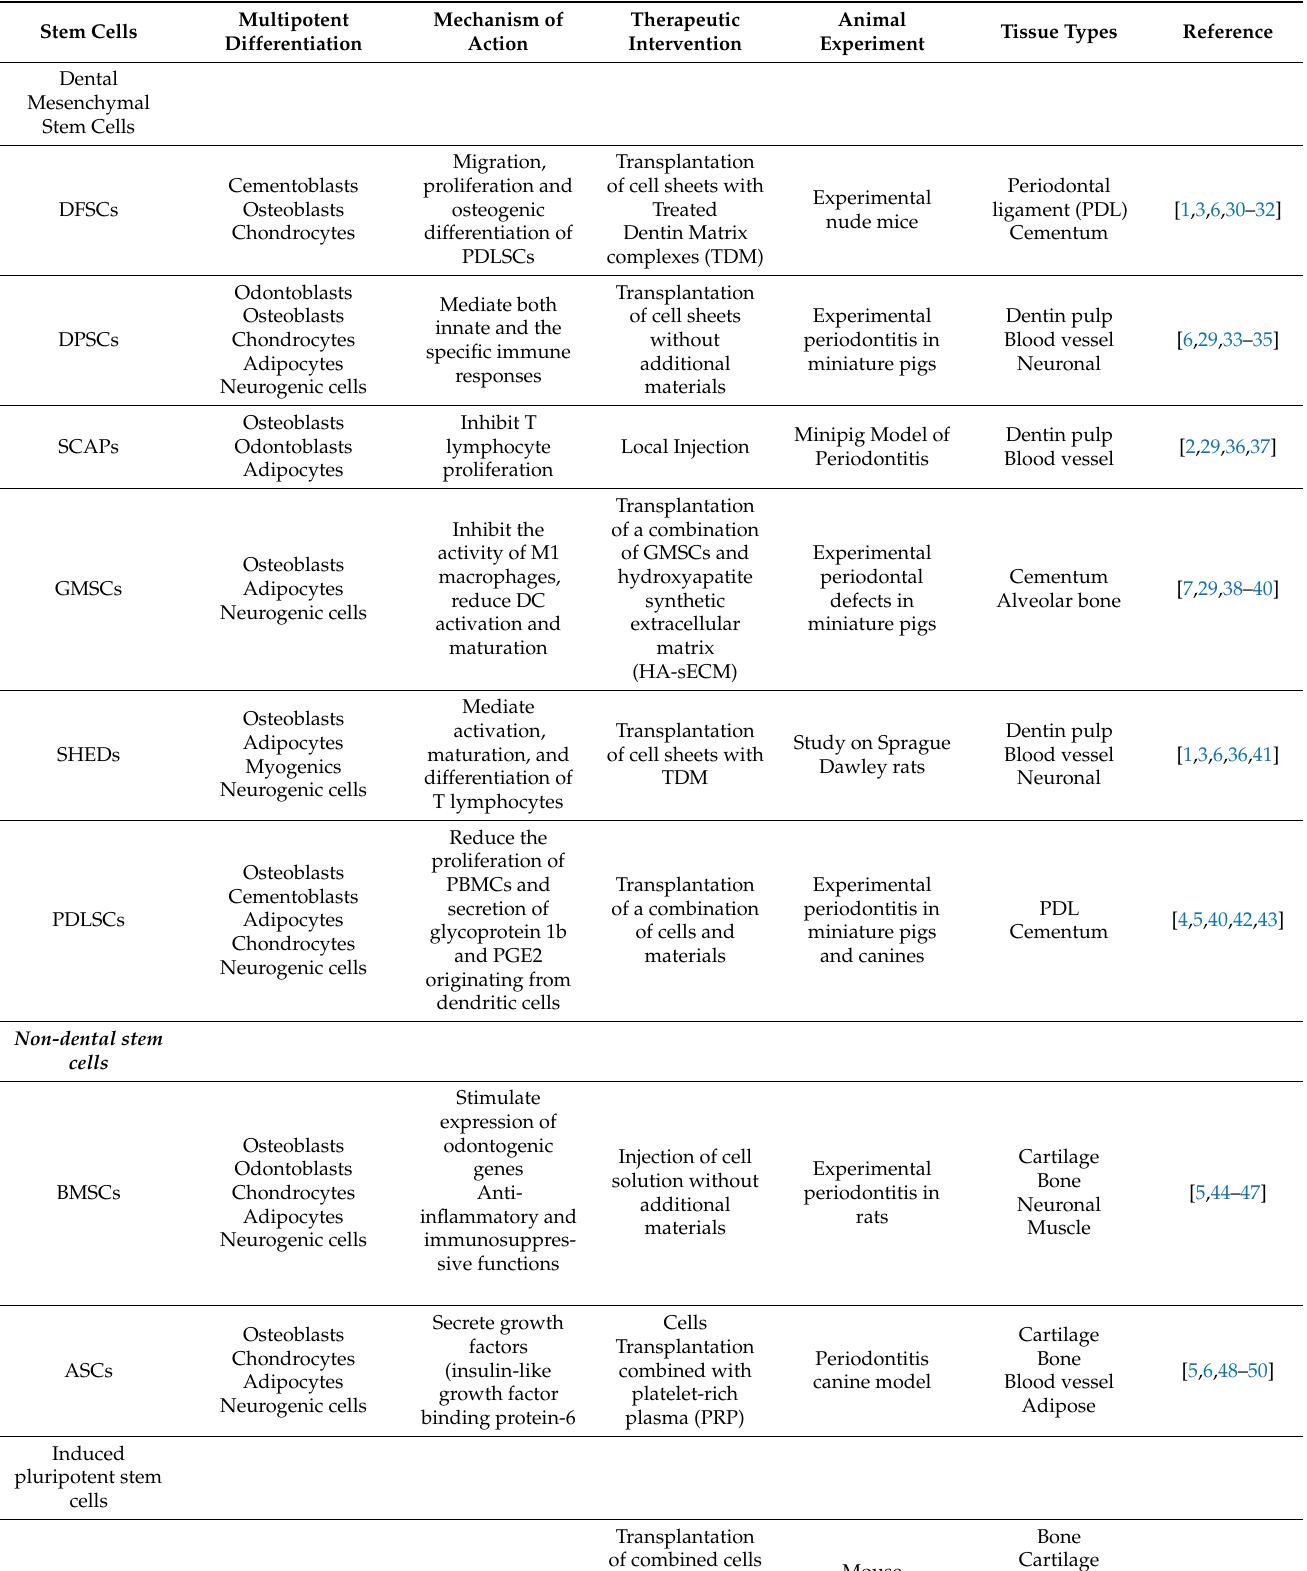
Table 1. Stem cells and multipotent differentiation at the level of distinct